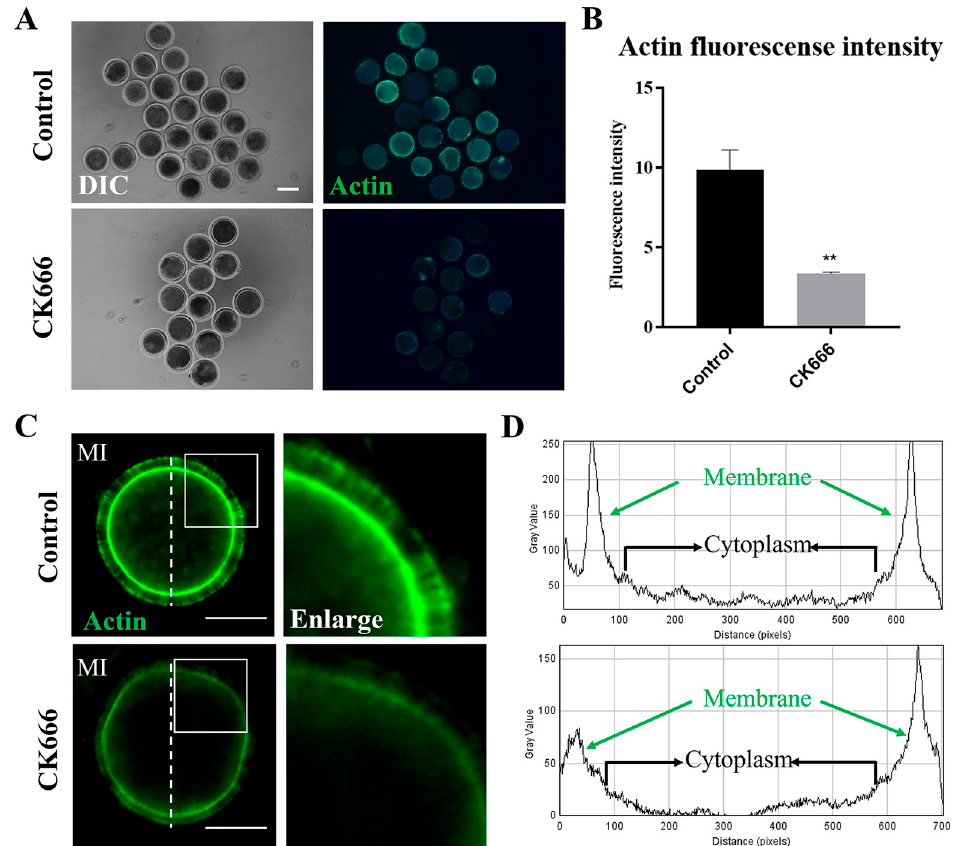
Figure 3. Inhibition of Arp2/3 complex affects actin assembly in goat oocytes. ( A ) A selection of images of F-actin in control and CK666-exposed oocytes. Green, F-actin. Bar = 100 µ m. ( B ) The fluorescence intensity of F-actin signals was quantified in oocytes that were either control or CK666- exposed. **, p < 0.01. ( C , D ) The data presented in the graphs demonstrated the fluorescence intensity of actin filaments in oocytes that were exposed to either a control or CK666. The brightness of the pixels was measured along the lines drawn across the oocytes.